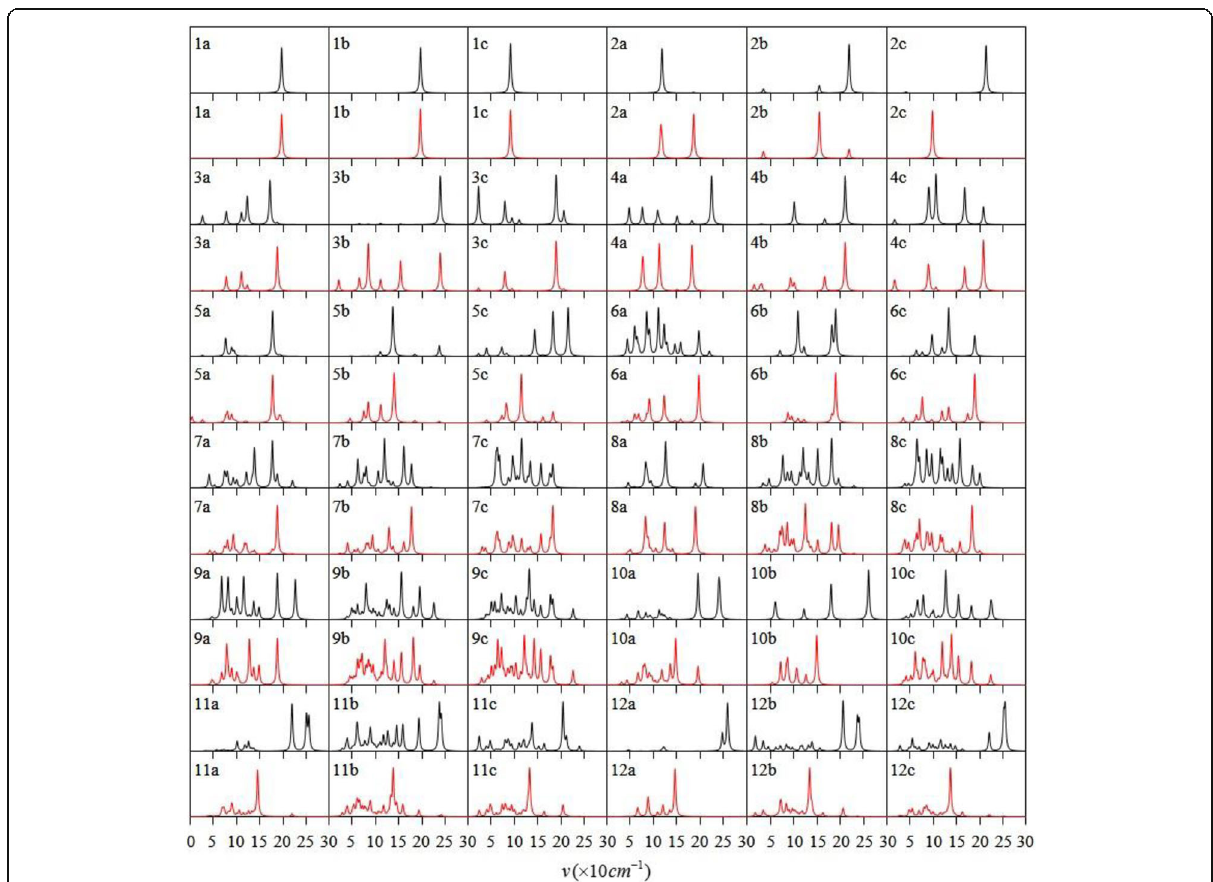
Fig. 3 The infrared spectra (black) and Raman spectra (red) of the ground state and two low-lying isomers of Ag n V ( n = 1 – 12) clusters